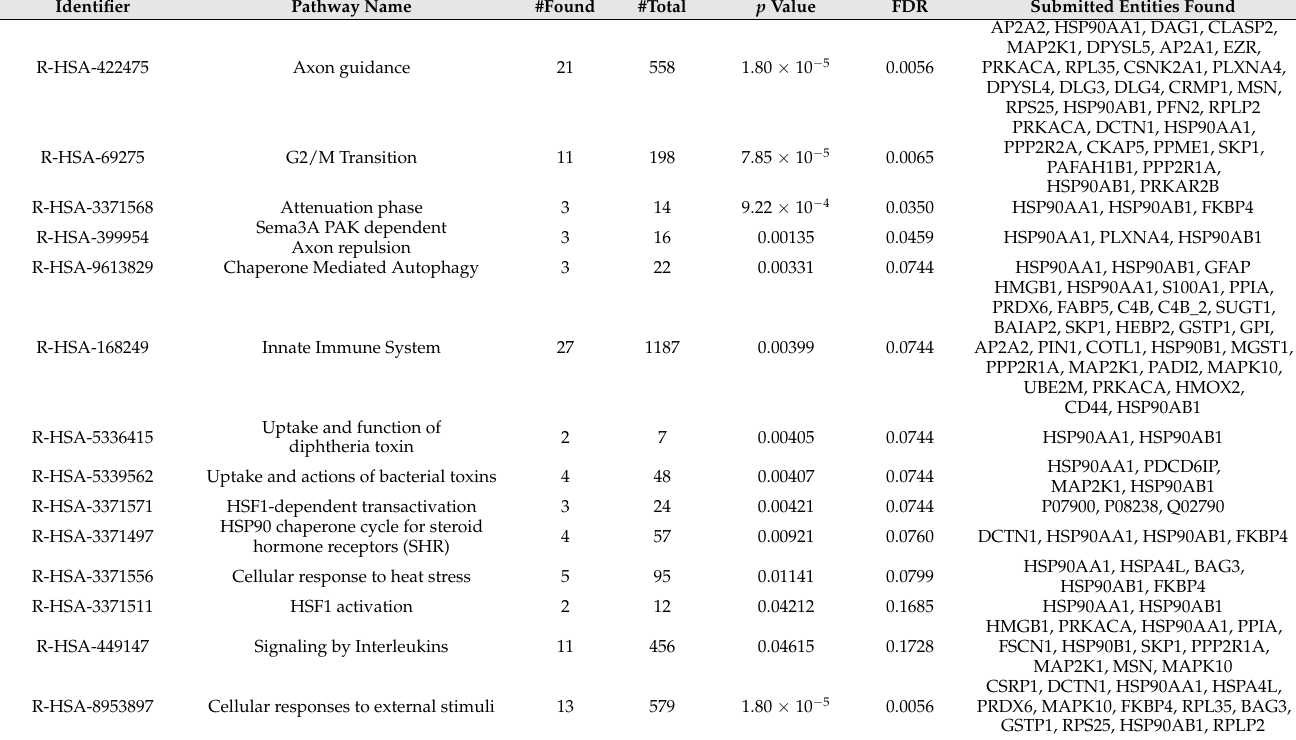
Table 2. Reactome pathways. Table shows pathways in which proteins identified as chaperones in STRING diagram are involved ( p value <